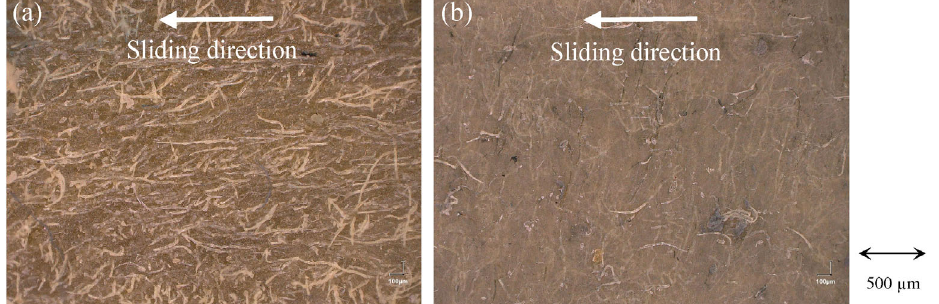
Fig. 4 Wear surfaces after tribometer tests: (a) composite 15 SF at a contact pressure of 0.2 MPa and (b) composite 20 SF+silica at a contact pressure of 0.8